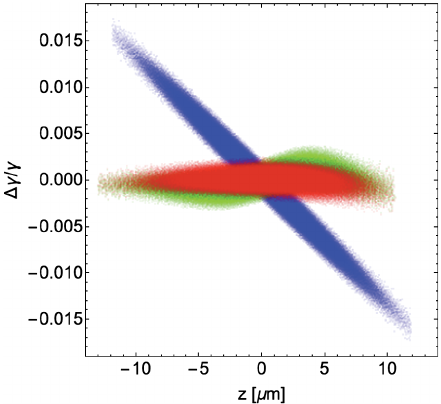
FIG. 14. The rms beam sizes (a); the total energy spread and chirp (b) and eigenemittances (c), at a distance s along the beam line of the TCAV-based dechirper at 1 GeV for Twiss parameters β